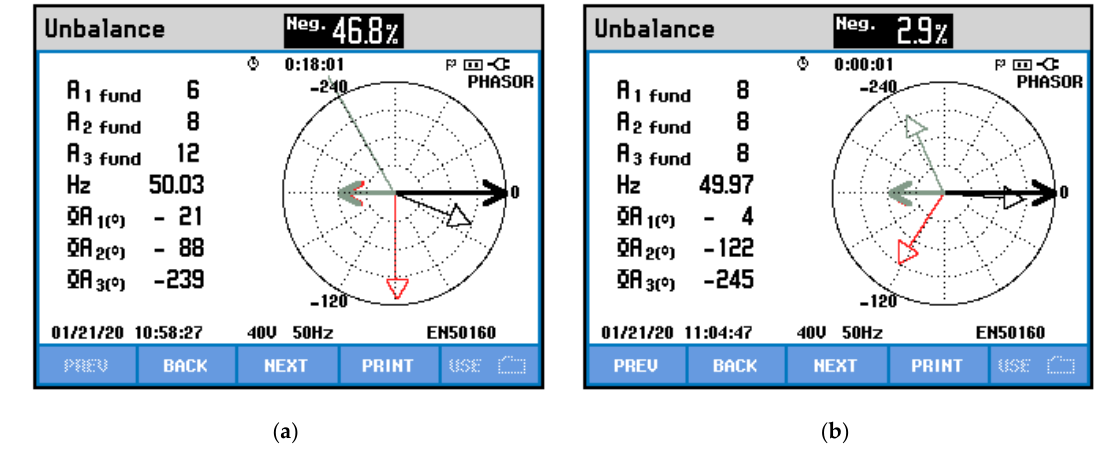
Figure 22. Unbalance ratio and phasors diagram of three-phase currents at the secondary of the V/V transformer (when two load sections are loaded): ( a ) before compensation; ( b ) after compensation.